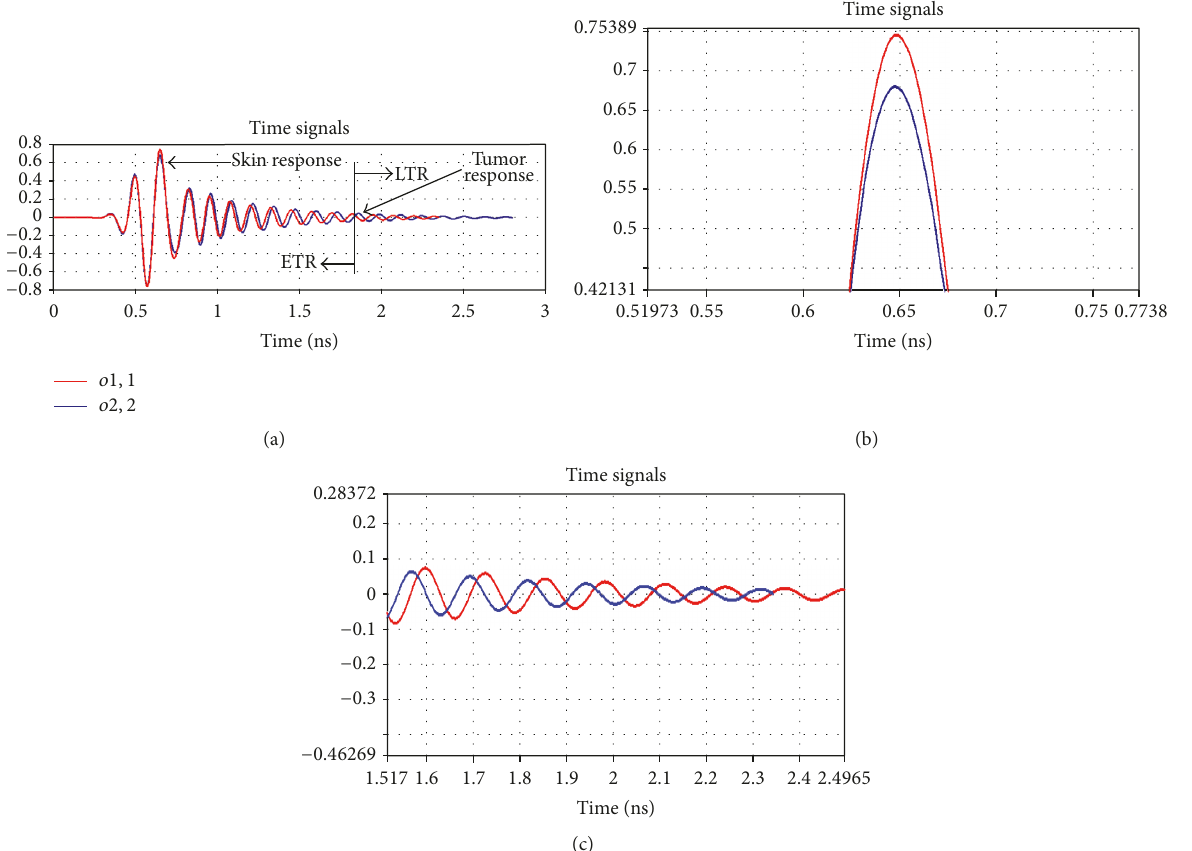
Figure 12: (a) Reflected transient signal by simulating antenna using head phantom with and without tumor, (b) enlarged skin response, and (c) enlarged tumor response.